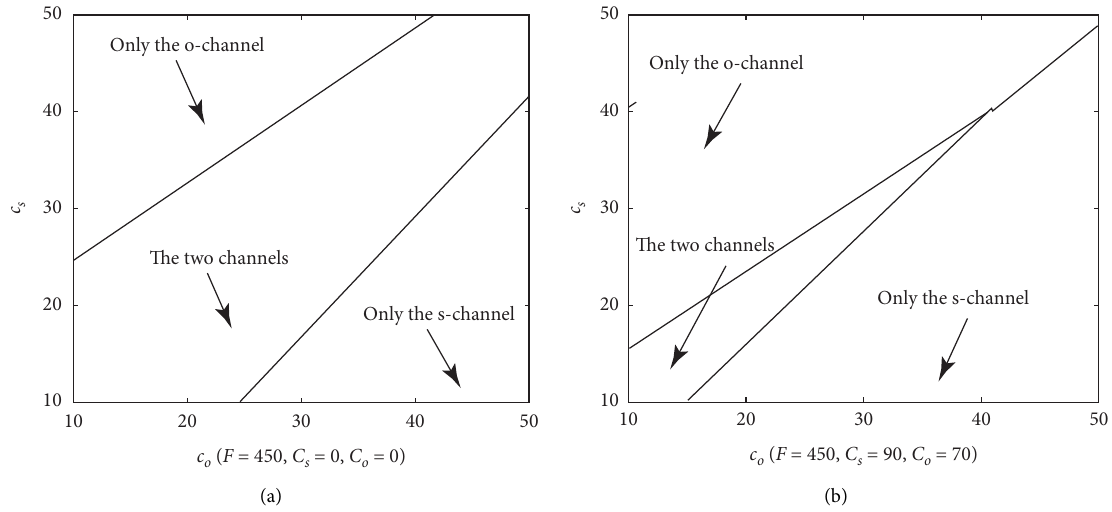
Figure 1: The channel selection strategy when borrowing is